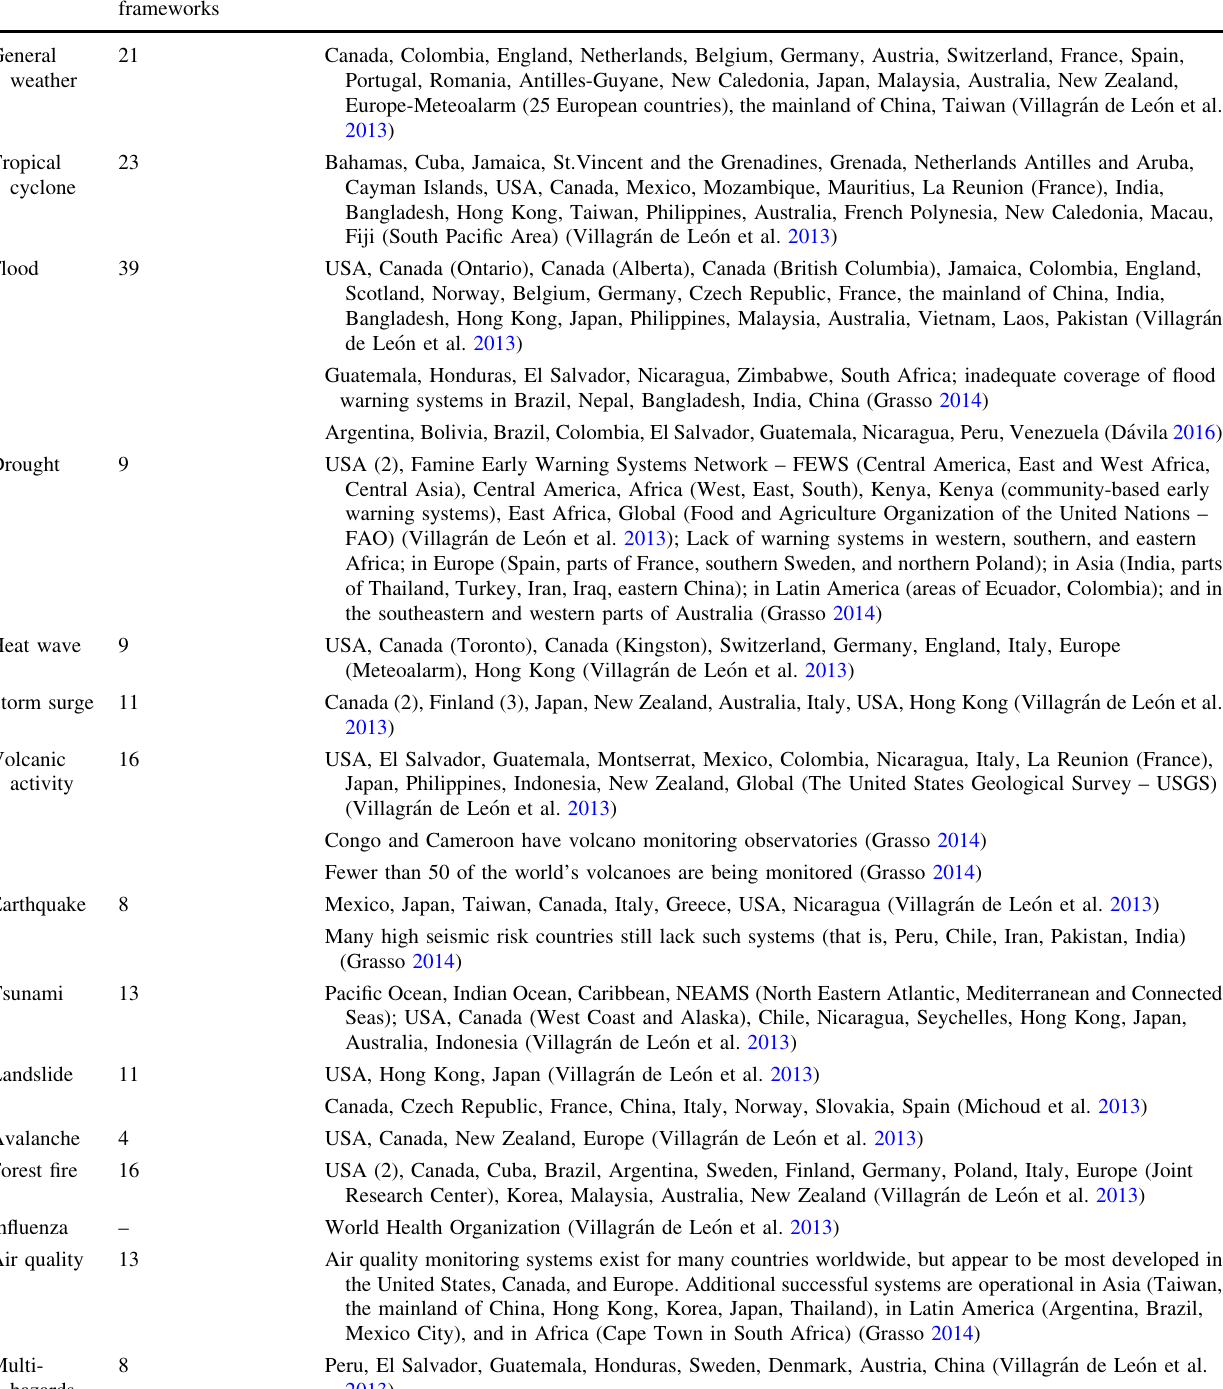
Table 1 Hazards, number of warning frameworks, and coverage Hazard Number of EWS